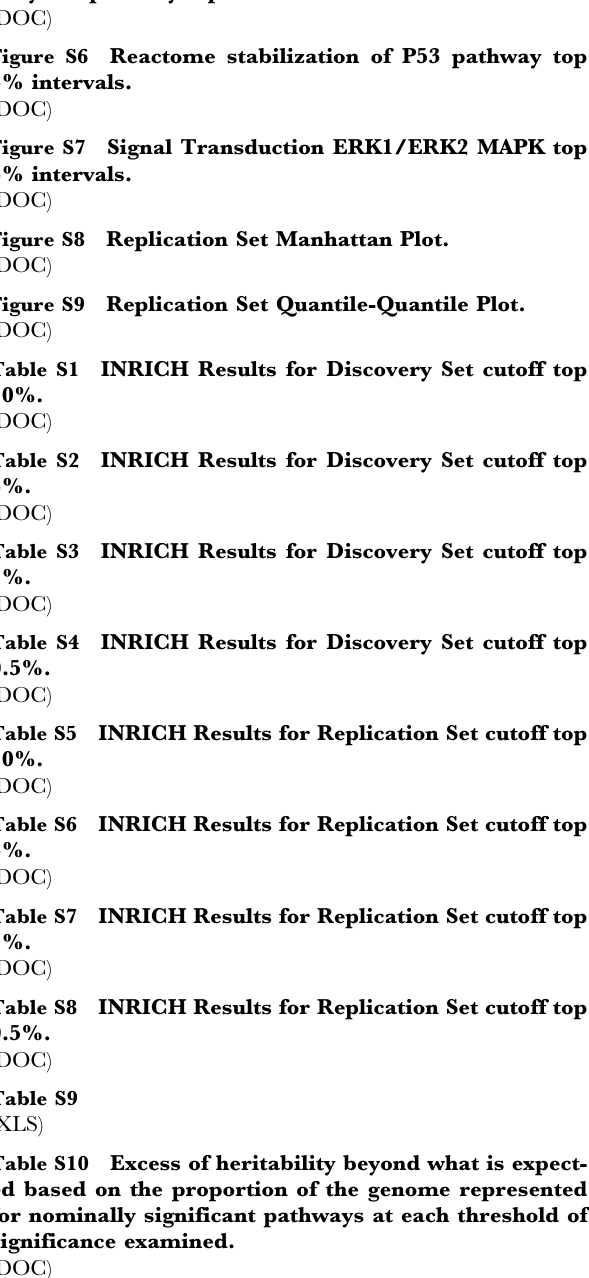
Figure S1 KEGG Fc epsilon RI signaling pathway intervals threshold top 10%. (DOC) Figure S2 KEGG Lysosome pathway top 0.5% intervals. (DOC) Figure S3 KEGG Lysosome pathway top 1% intervals. (DOC) Figure S4 KEGG Toll-like receptor-signaling pathway top 5% intervals. (DOC) Figure S5 The Reactome regulation of ornithine decar- boxylase pathway top 5% intervals. (DOC) Figure S6 Reactome stabilization of P53 pathway top 5% intervals. (DOC) Figure S7 Signal Transduction ERK1/ERK2 MAPK top 5% intervals. (DOC) Figure S8 Replication Set Manhattan Plot. (DOC) Figure S9 Replication Set Quantile-Quantile Plot. (DOC) Table S1 INRICH Results for Discovery Set cutoff top 10%. Table S2 INRICH Results for Discovery Set cutoff